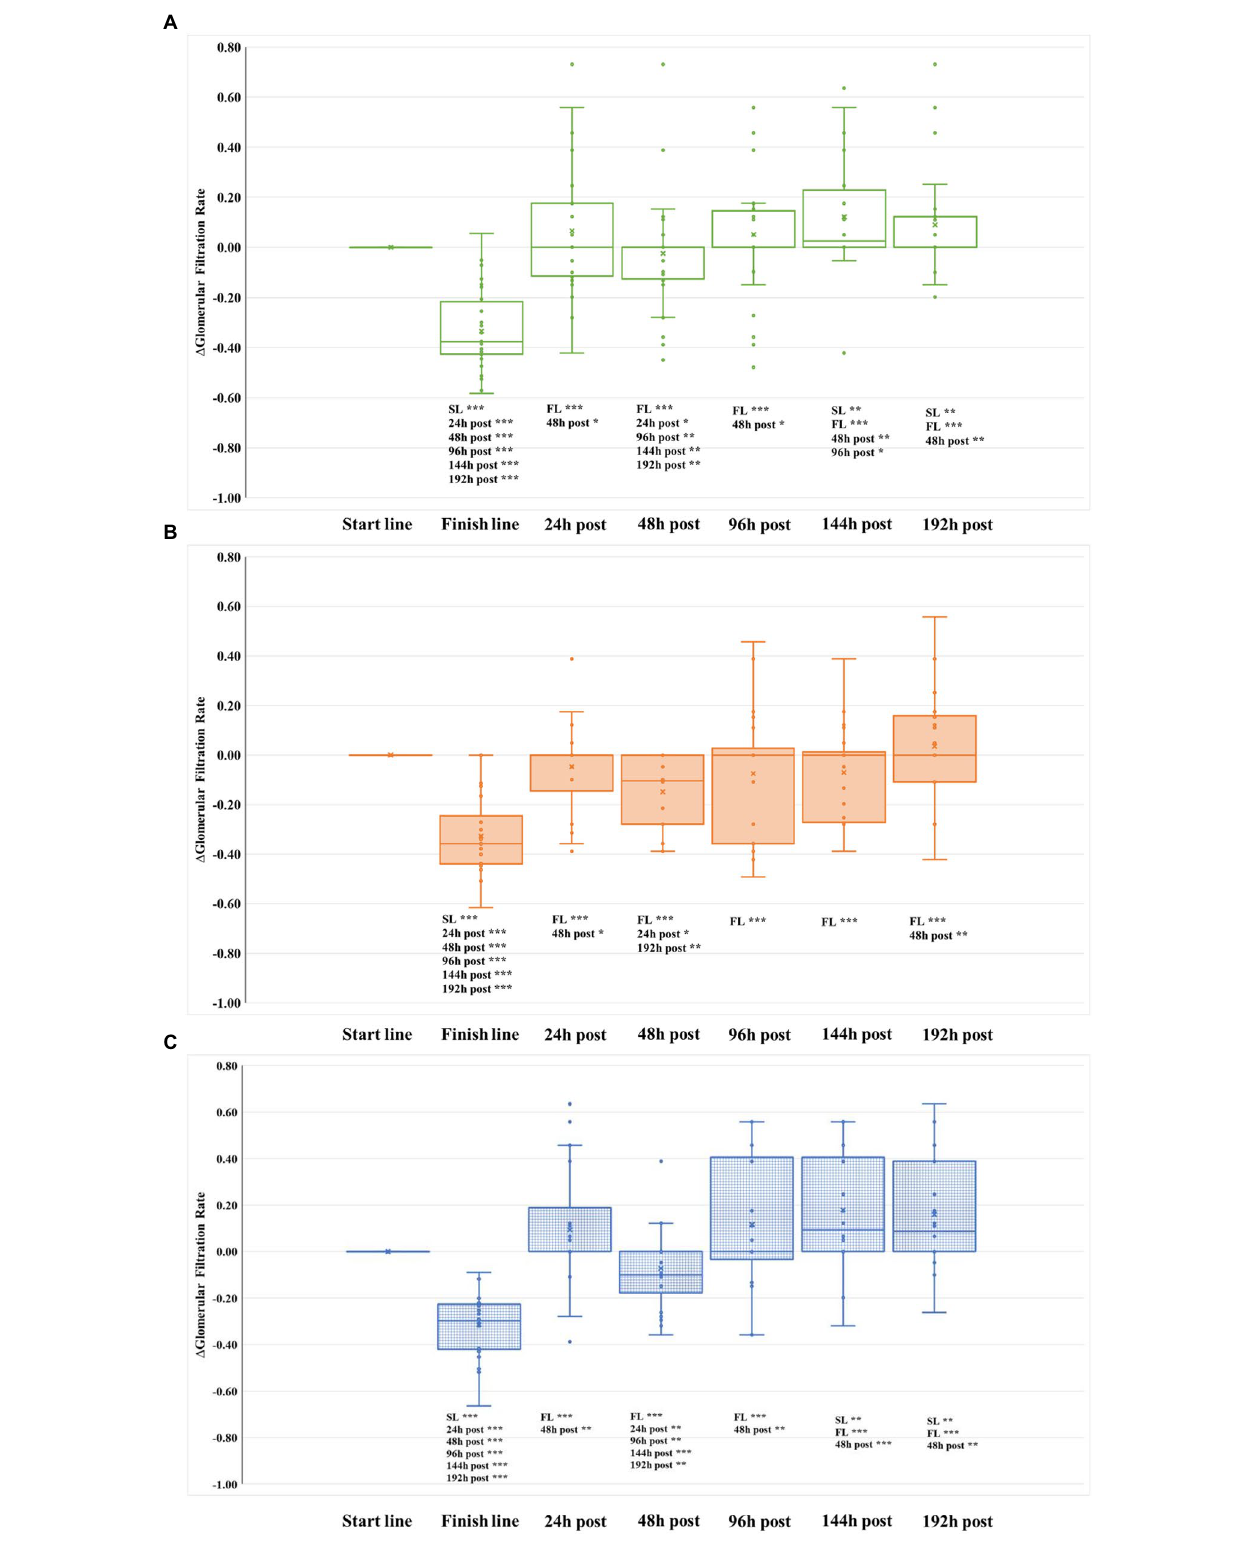
FIGURE 1 | Evolution of glomerular filtration rate relative to baseline ( ∆ GFR) in the three groups during the whole study. (A) REST group. (B) ELLIPTICAL group. (C) RUNNING group. SL, start line; and FL, finish